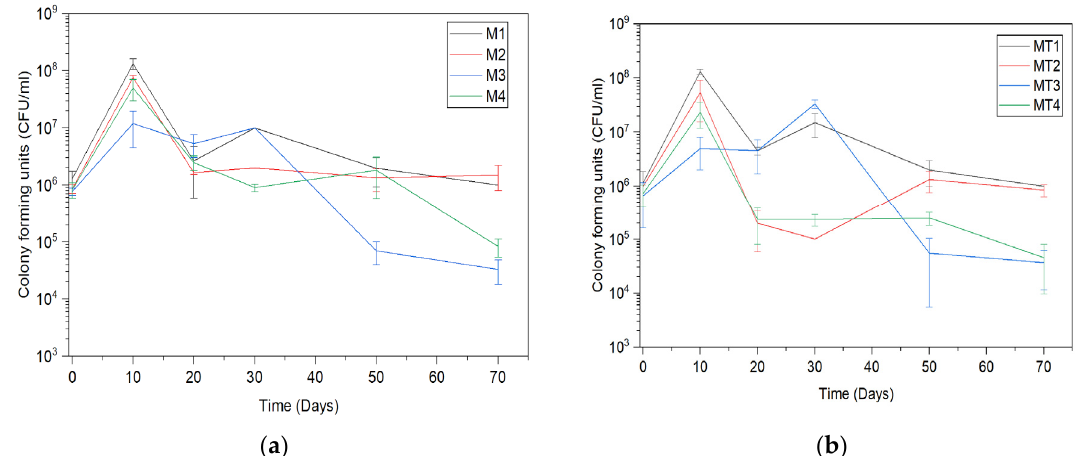
Figure 3. CFU counts in peat during its storage at 30 °C in ( a ) medium without 1% Tween 80, ( b )